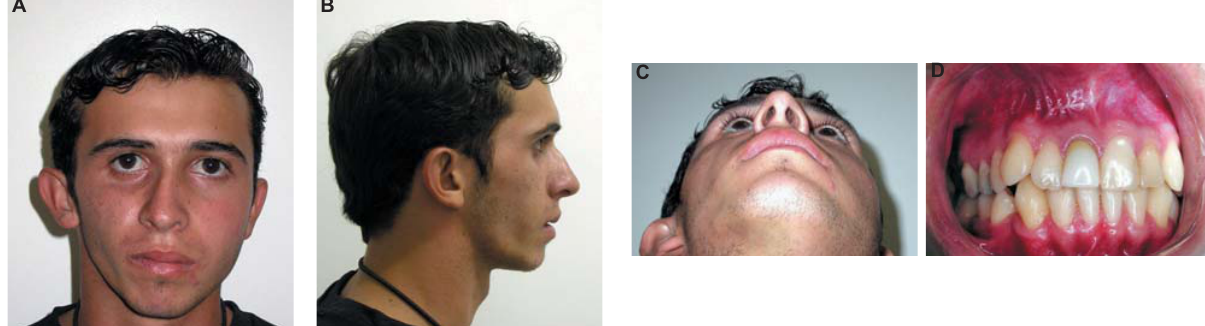
Figure 5A-D- Evaluation at 20 days postsurgery (patient signed informed consent authorizing the publication of these pictures) A B